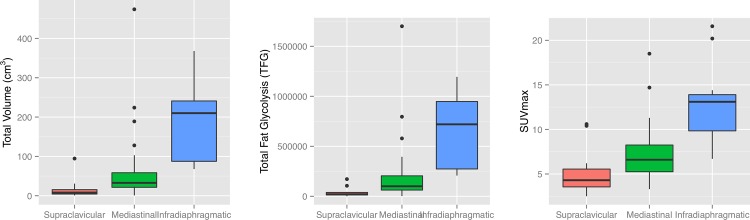
Quantification of glycolysis in the different depots.A clear increase of all three metabolic PET-parameters MFV, TFG and SUVmax, from the supraclavicular depots to the more caudally located infradiaphragmatic depots can be appreciated.